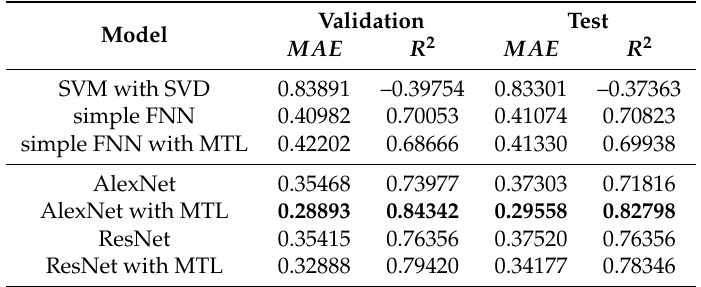
Table 3. The regression result of the tasks with different models.